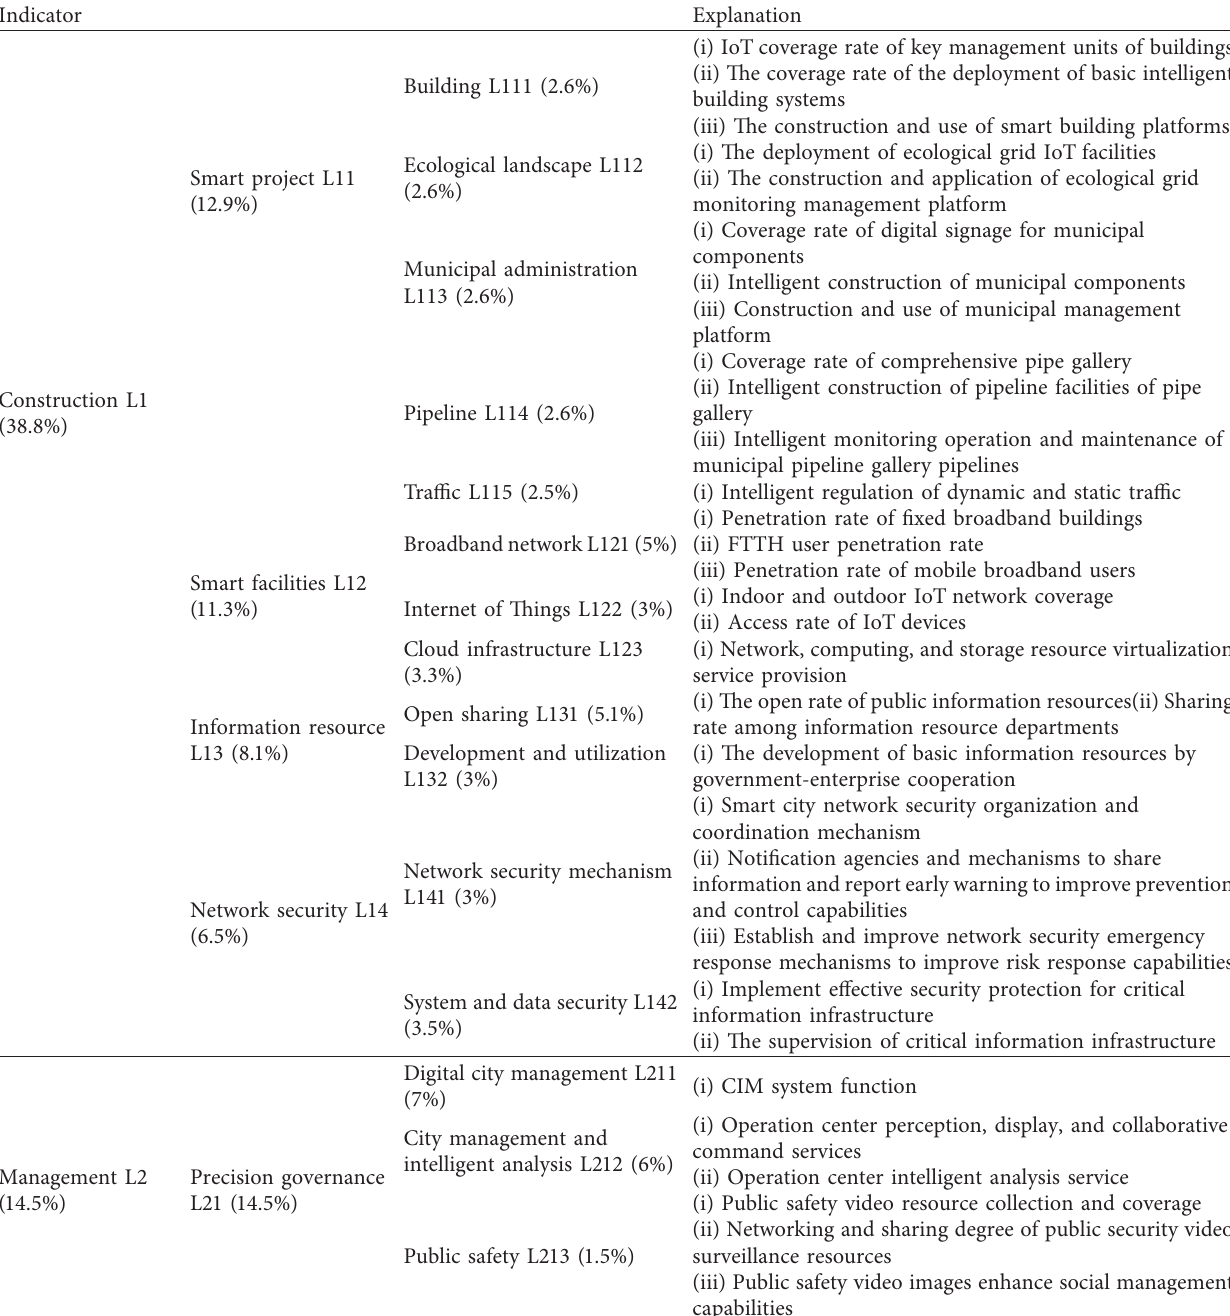
Table 2: Construction effect evaluation indicators for the smart